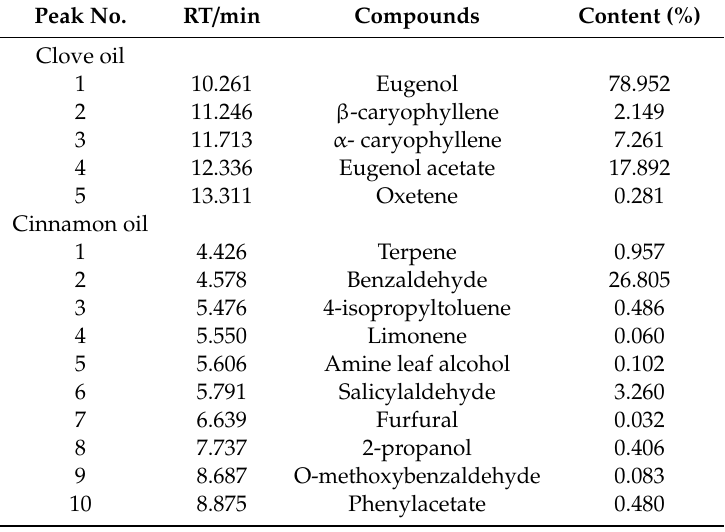
Table 2. The main components of the essential oils of clove and cinnamon oil analyzed by GC–MS. Peak No. RT /